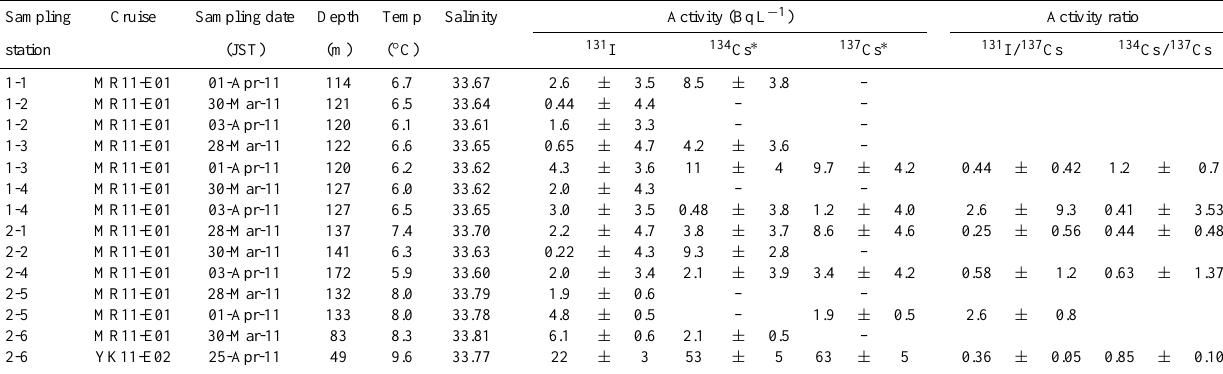
Table 3. Hydrographic parameters, activities, and activity ratios of 131 I, 134 Cs, and 137 Cs in the water below the surface layer ( ≤ 5m). Sampling